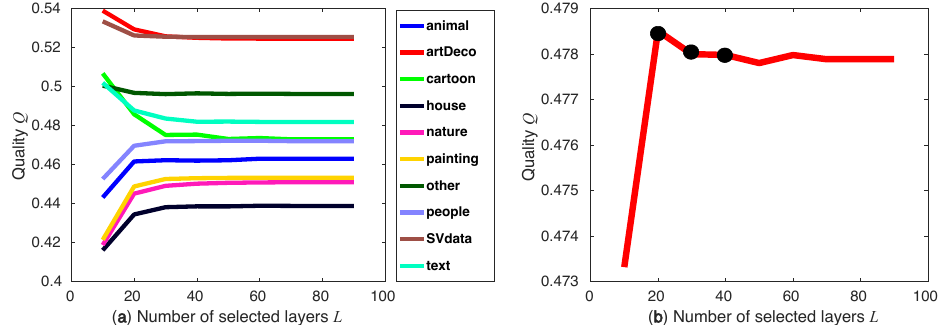
Figure 5. Quality Q as a function of number of layers L . ( a ) Q plots per image type. ( b ) Average Q for all image types. Black dots indicate good L values (20, 30, and 40).